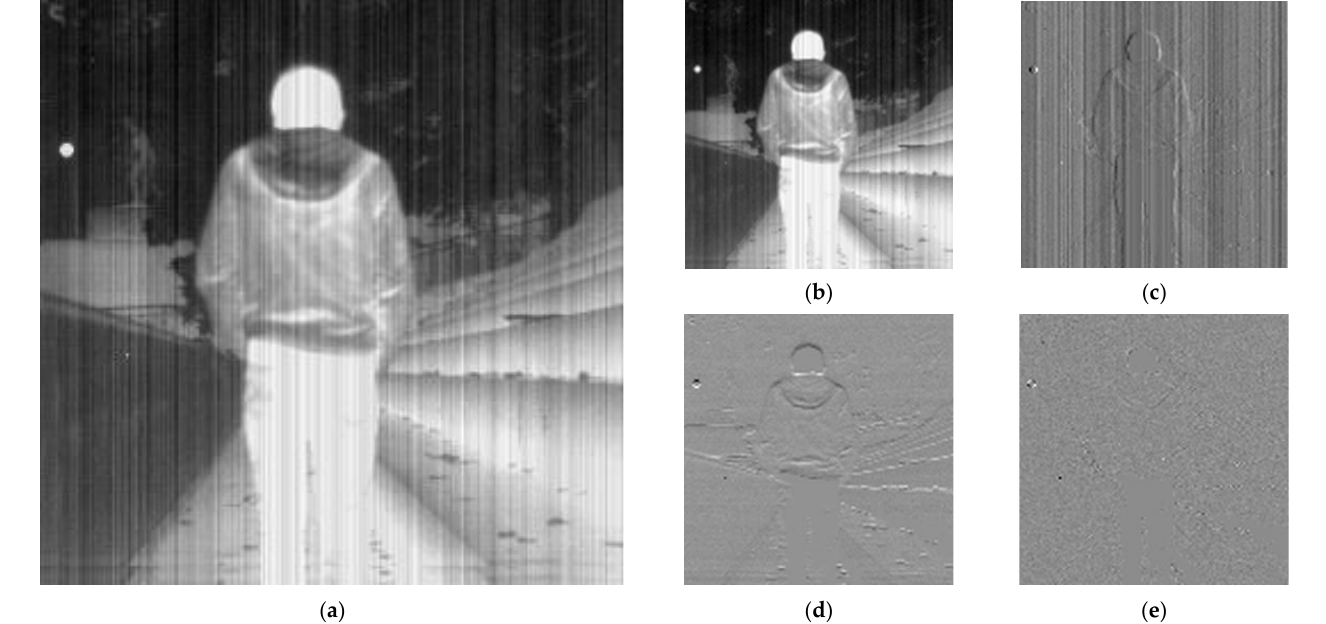
Figure 9. The DWT of the strip noise corrupted image. ( a ) Noise corrupted image; ( b ) approximation coefficients; ( c ) horizontal coefficients; ( d ) vertical coefficients; ( e ) diagonal coefficients.